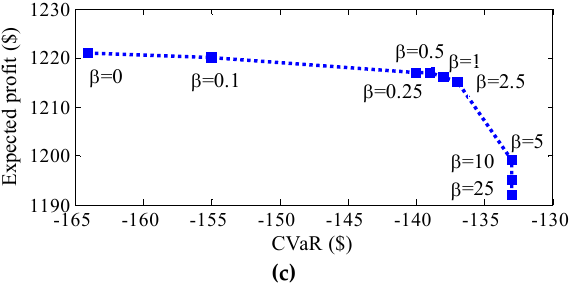
Figure 4. Operator’s expected profit versus conditional value ‐ at ‐ risk (CVaR) in different wind penetration levels: ( a ) Wind penetration level = 0%; ( b ) Wind penetration level = 50%, and ( c ) Wind penetration level = 100%.